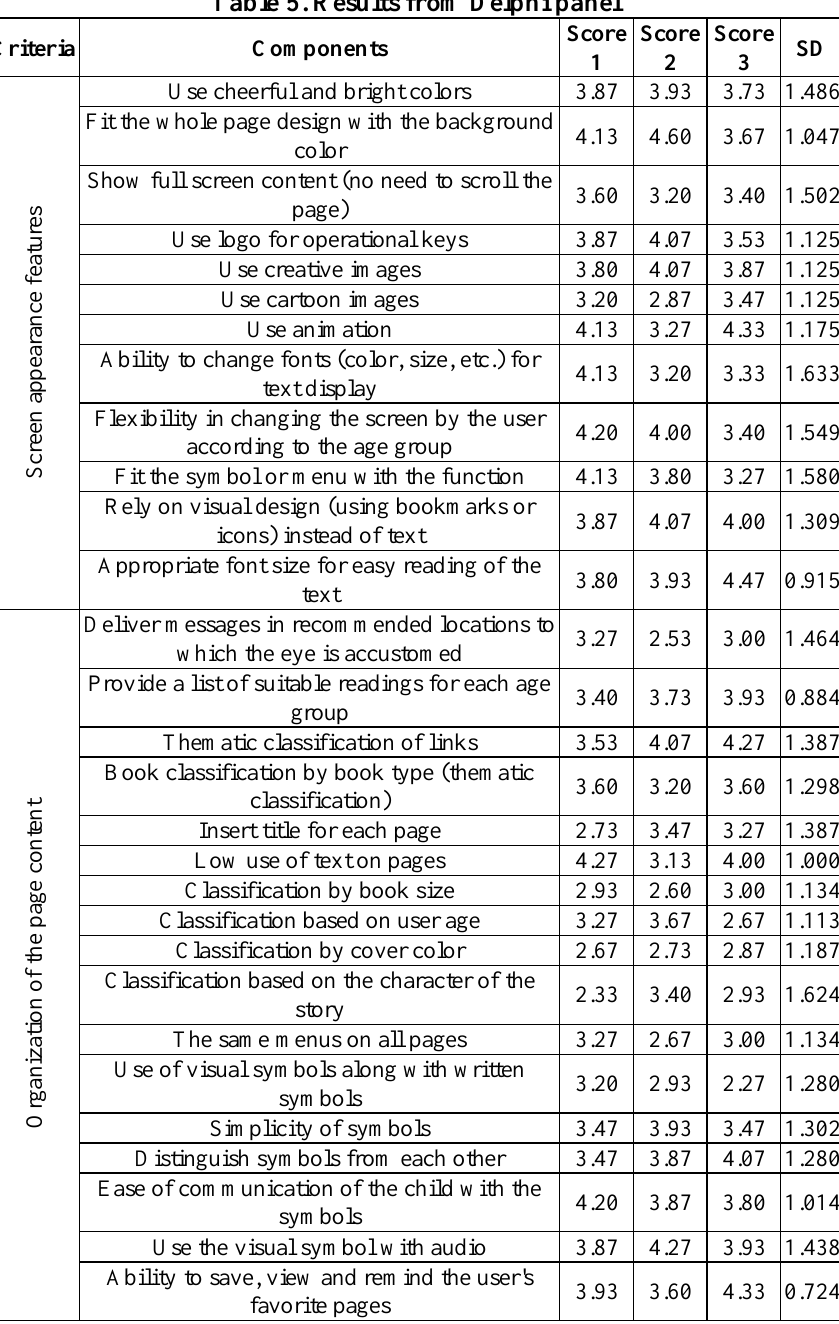
Table 5. Results from Delphi